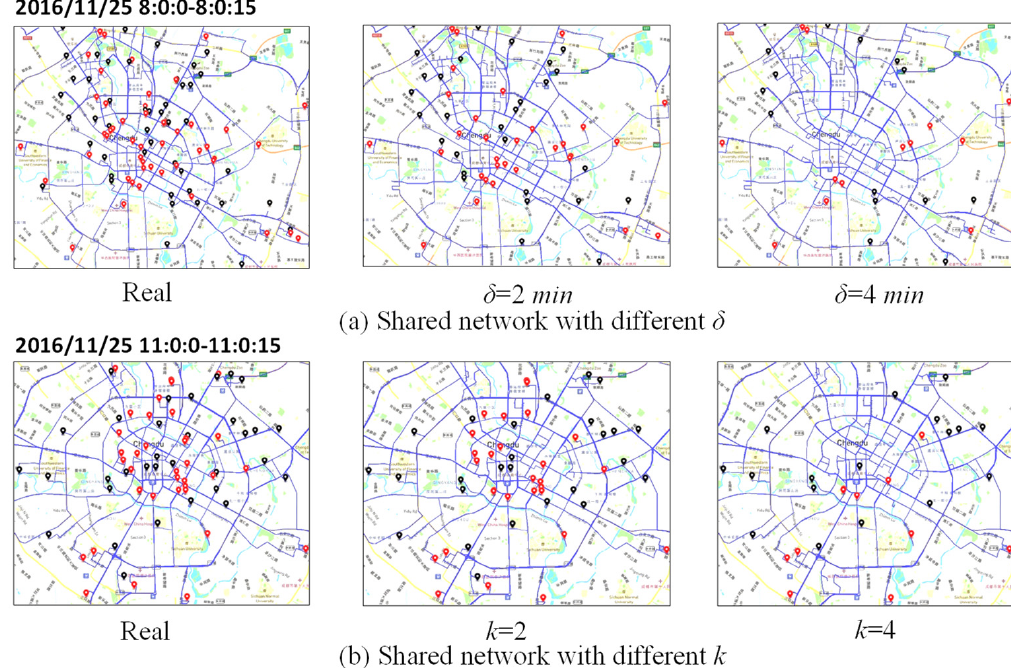
Figure 9. Example of a trip sharing network for 15s; the blue line is the path, the black marker indicates the origin, and the red is the destination of the trips. ( a ) shows the shared network based on different δ and ( b ) based on different k .